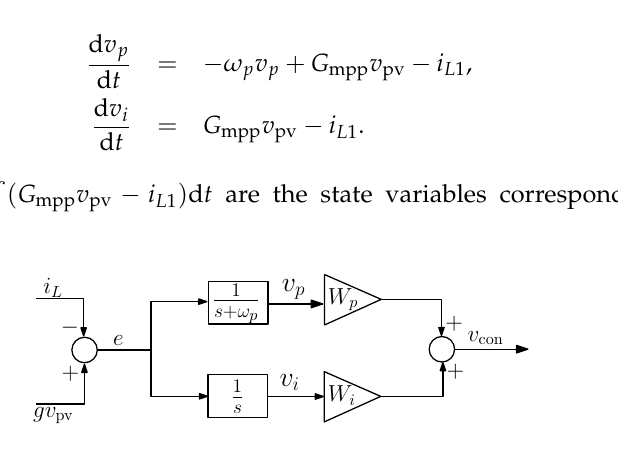
Figure 6. Equivalent block diagram of a type-II